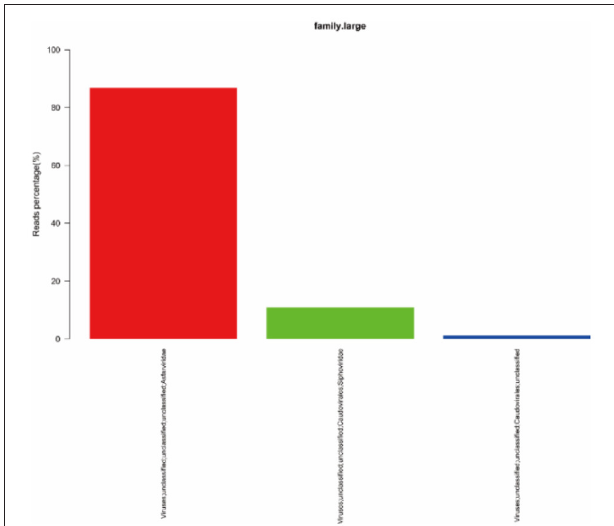
Table 1 . According to the annotation information of the NCBI